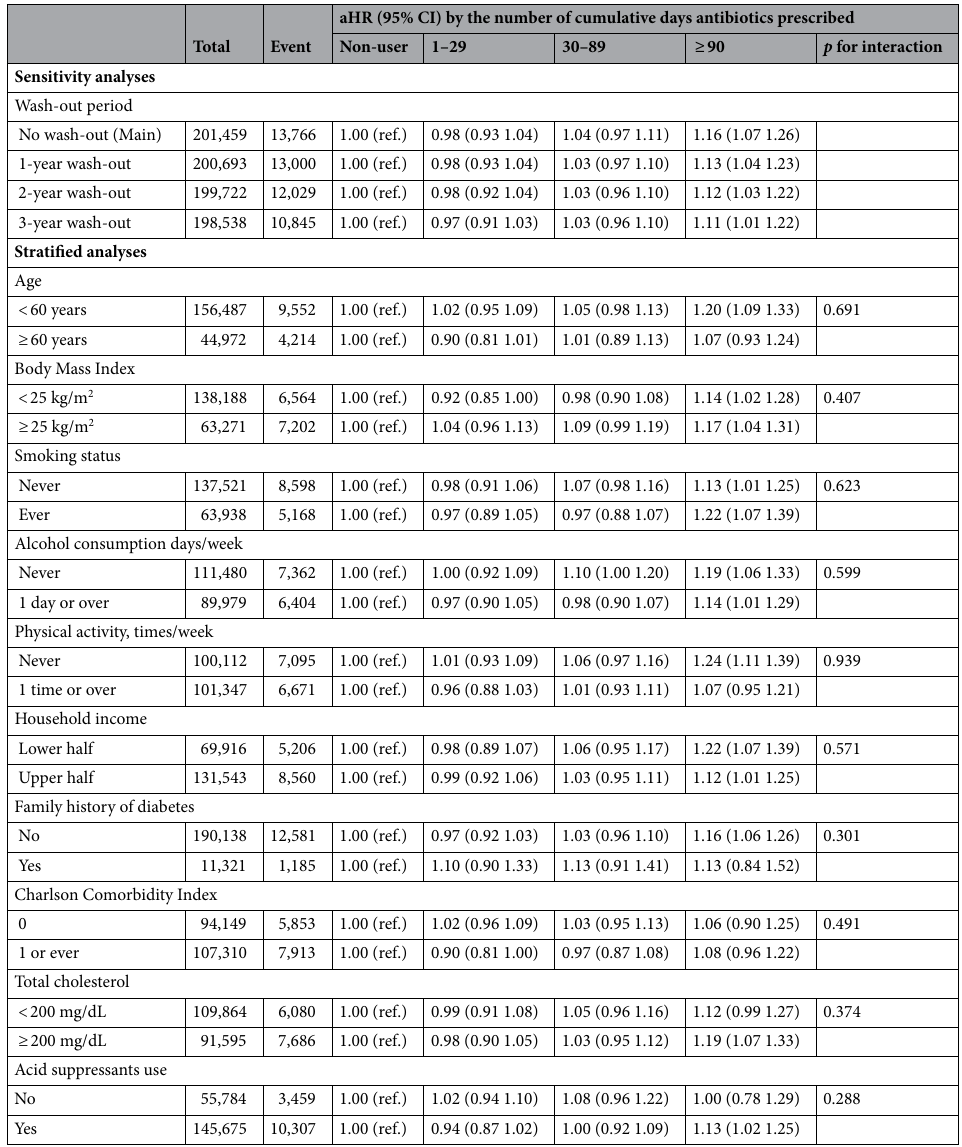
Table 3. Sensitivity analyses and stratified analyses of association between antibiotics use and diabetes incidence. aHR adjusted hazard ratio, CI confidence interval, ref. reference. Model Adjusted for age, sex, body mass index, smoking status, days with alcohol drinking per week, physical activity, household income, residence, family history of diabetes, Charlson comorbidity index, fasting blood sugar, total cholesterol, and acid suppressants use. The estimates were based on fully adjusted